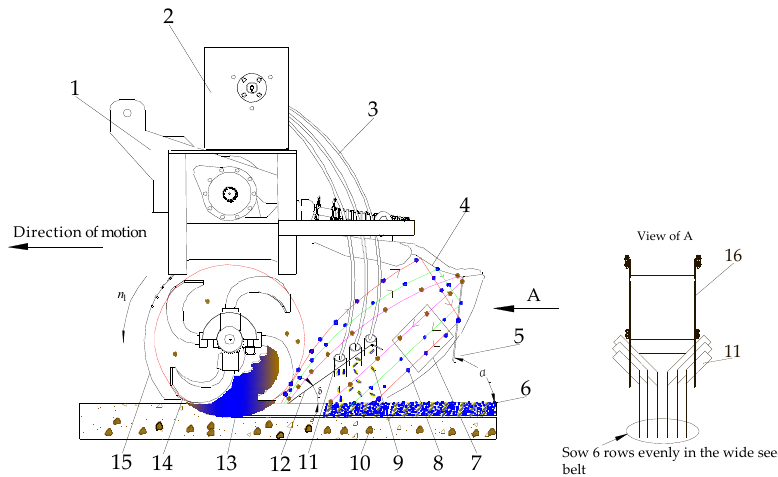
Figure 4. Working principle diagram of a soil-throwing and covering device after wheat wide seed belt: (1) rack; (2) seed box; (3) seed tube; (4) upper retaining plate (5) rear retaining plate; (6) finely ground soil after rotary tillage; (7) soil throwing track; (8) finely ground soil particles; (9) wheat; (10) rough soil in non-rotary tillage area; (11) seed guide tube (12) soil guide plate; (13) thrown finely ground soil; (14) rotary blade; (15) rotary blade baffle; (16) side